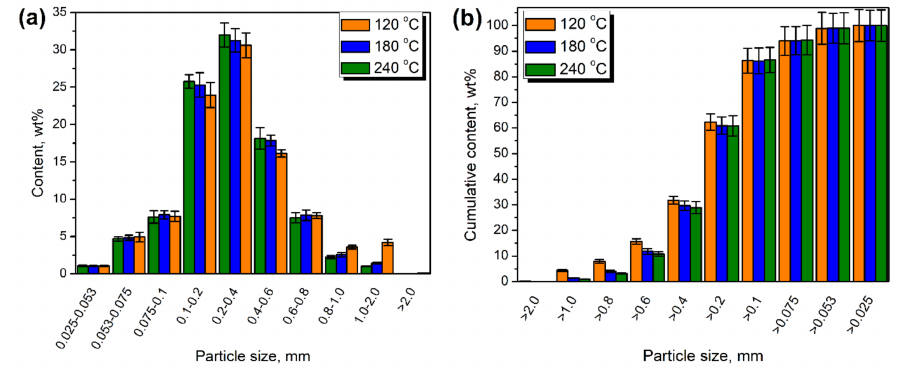
Figure 5. Plots showing ( a ) share of particles with a given diameter, and ( b ) cumulative particle size distribution of modified